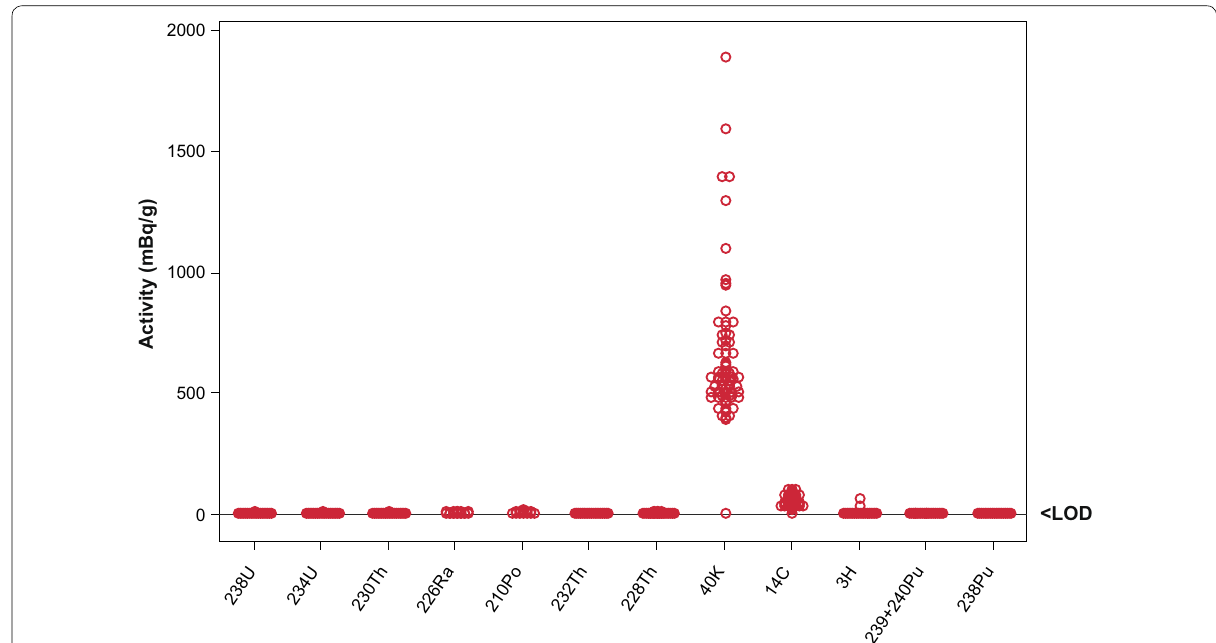
Fig. 3 Activities of radioisotopes (mBq/g product wwb) detected in US and Swedish STPs. Activities below LoD are displayed as 0 in the graph